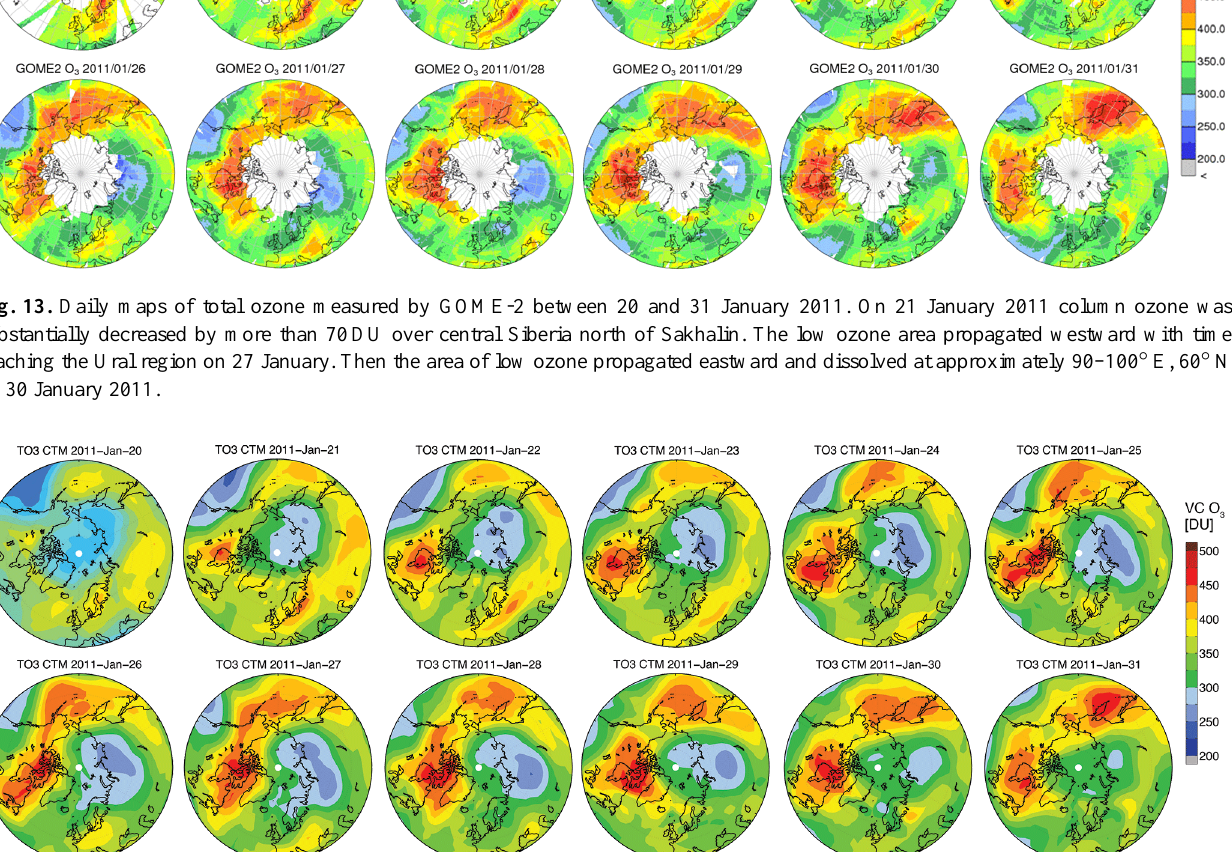
for so-called “ozone mini-hole” events, which are caused by the intrusion of subtropical air masses with a high tropopause (e.g. Weber et al.,